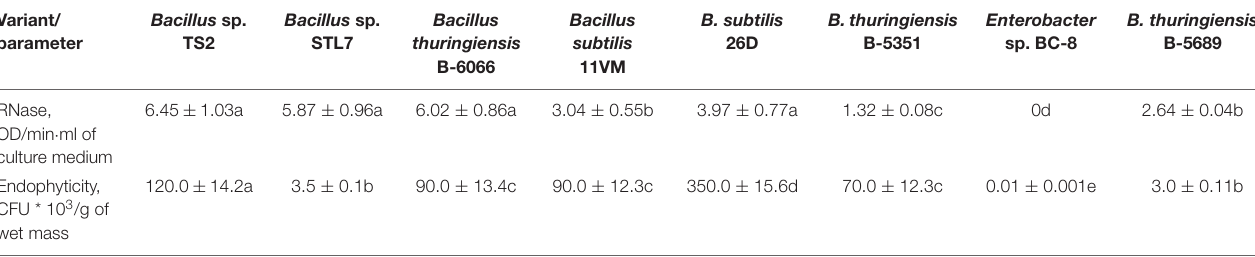
TABLE 3 | RNase activity of bacterial strains in vitro and its CFU content in internal tissues of potato stems. Variant/